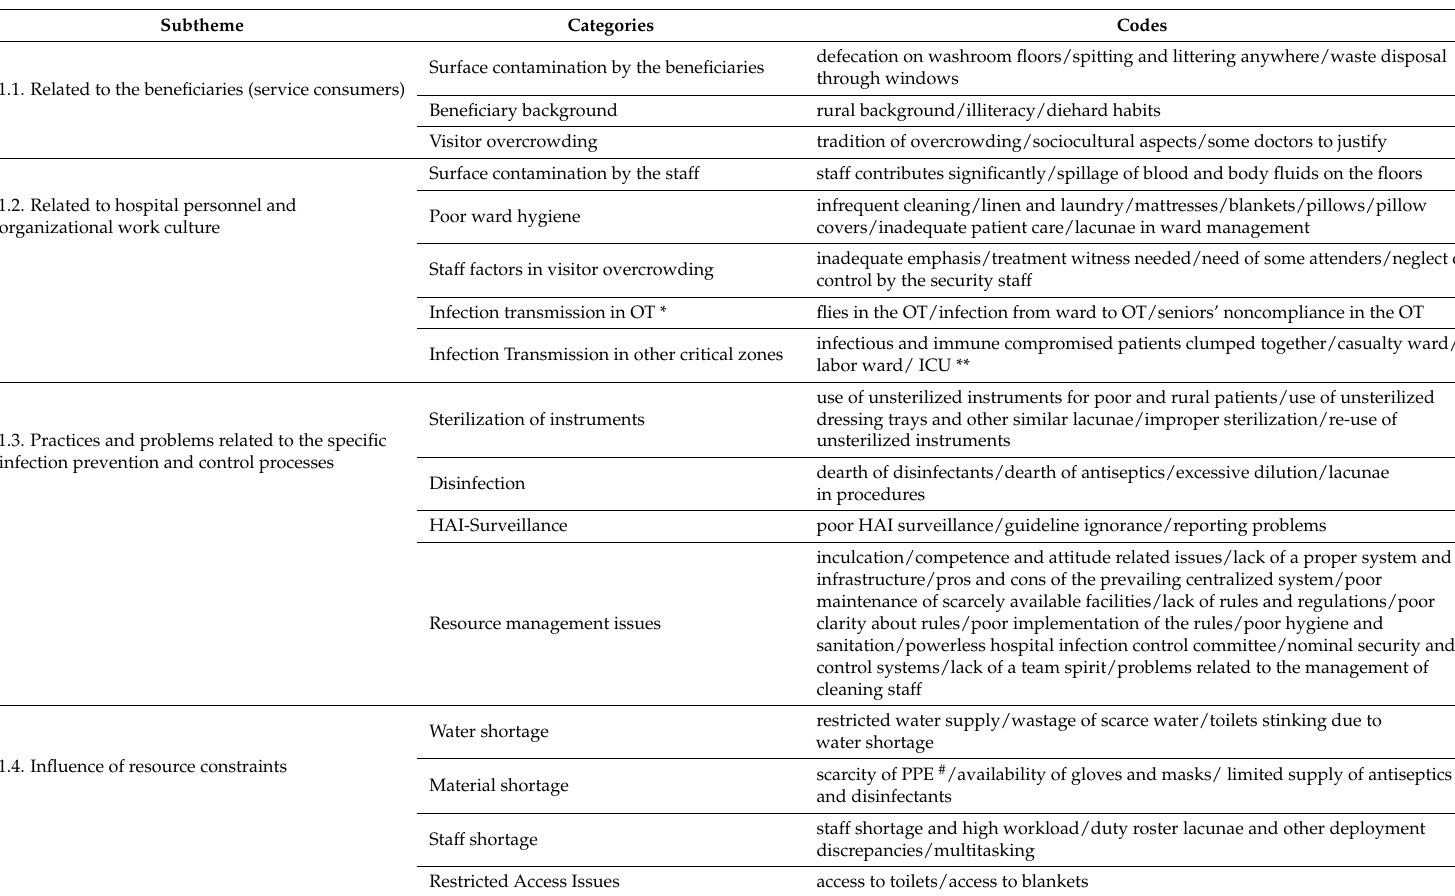
Table 2. Theme 1—Prevailing practices and problems related to hospital surface/object contamination and hospital infection